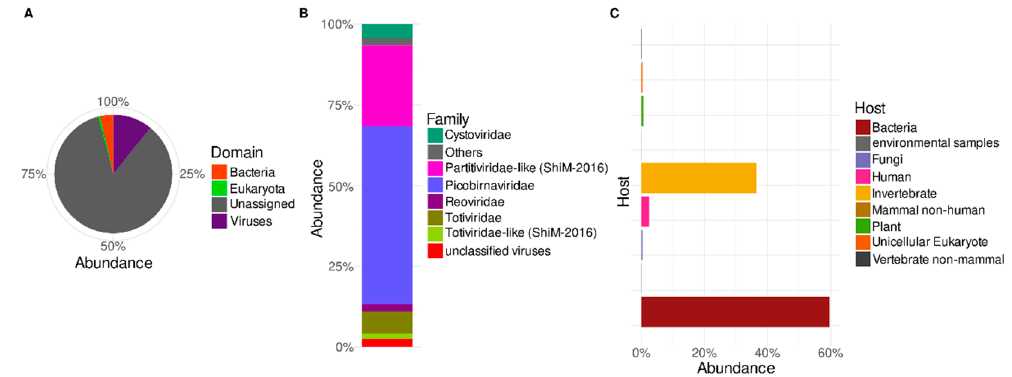
Figure 2. Relative abundances of predicted protein sequences in Trebal viral RNA metagenome, classified by LCA algorithm trough local alignment to NCBI nr database. ( A ) Domain level, and ( B ) Family level for sequences classified as Virus in A. ( C ) Putative host for sequences classified as Virus in A. Sequences were normalized by protein length.